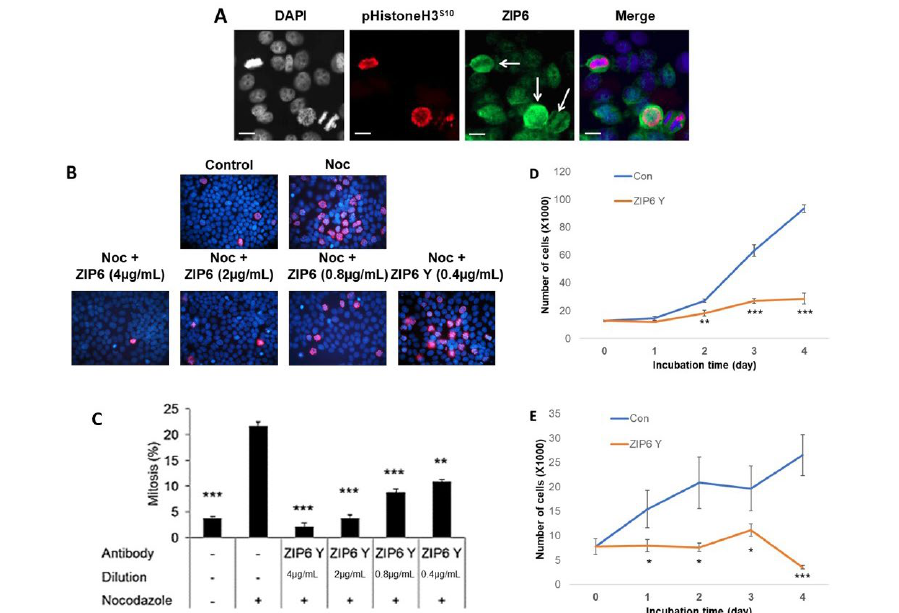
Figure 2. Assessment of ZIP6 activity in regulating mitosis of cancer cells in vitro . (A) Immunofluorescent evaluation of phosphorylated ZIP6 (green) activity in MCF-7 cells, in comparison with pHistoneH3 S10 (red) as a marker for cells actively undergoing mitosis, plus additional co-stain for cell nuclei with DAPI (blue). White arrows identify cells undergoing active mitosis. Images are representative of multiple assessment ( n = 3). Scale bars represent 10 µm. (B) Cells were treated with 100 nmol/L nocodazole, in the presence or absence of anti-ZIP6 antibody across a dose range, for 20 h prior to examination of mitotic changes through counting cells positive for immunofluorescent detection of pHistoneH3 S10 (red). Cells nuclei were co-stained with DAPI (blue). Images are representative of replicate data ( n = 3). Quantification of results is shown in (C). Proliferation of MCF-7 (D) and TAMR (E) cells were assessed ± treatment with 4 µg/mL ZIP6 antibody. Cells were counted at 24 h intervals following initial treatment and at day 0 ( n = 3). All graphs display mean values with error bars representative of SEM; * P < 0.05, ** P < 0.01, *** P < 0.001. Noc: nocodazole; Con: